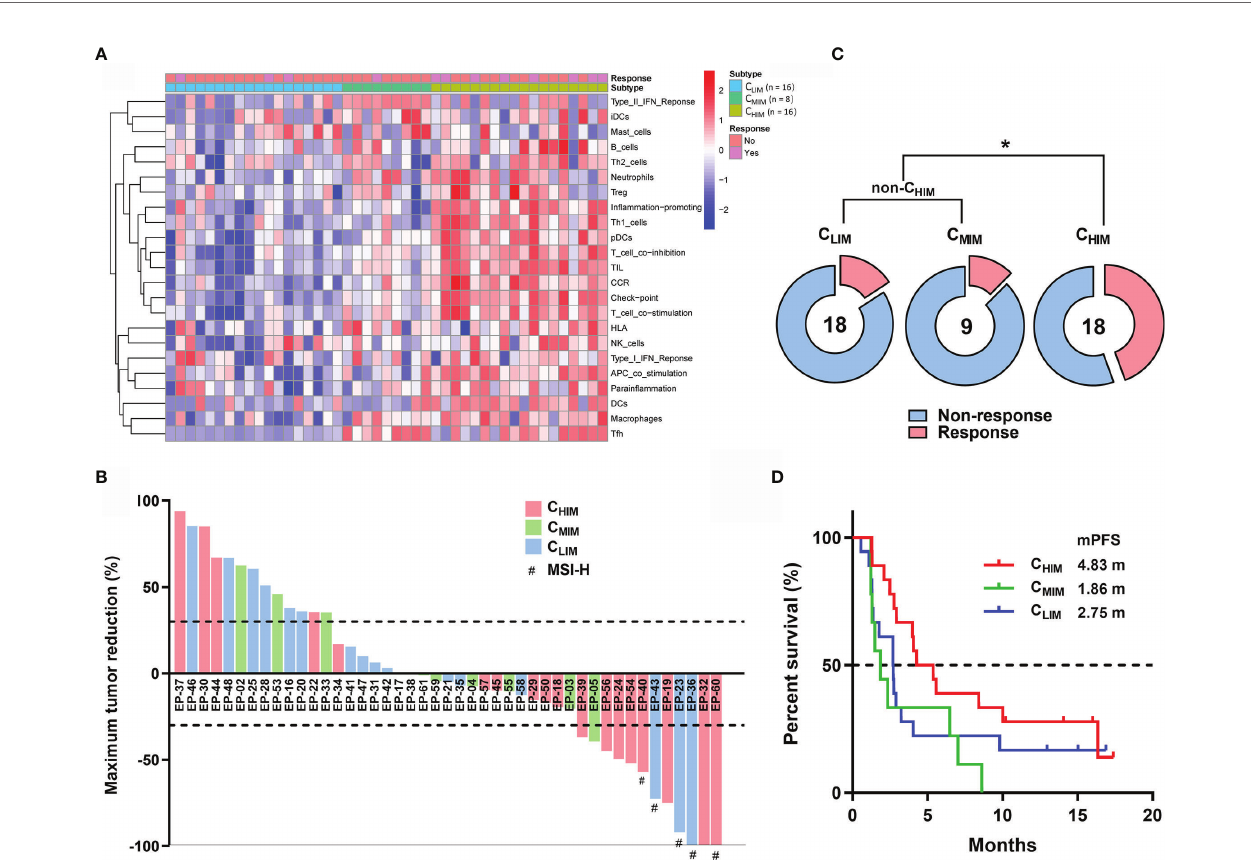
FIGURE 8 | Clinical outcome prediction by immune subtypes in patients treated with ICIs. (A) Clustering of patients in PRJEB25780 cohorts. (B) Waterfall plot of responses to ICIs (pembrolizumab) according to immune subtypes. The lower dotted line represents tumor reduction of 30% per RECIST and de fi nes partial responses. (C) Frequencies of patients with and without response to ICIs between different immune subgroups. (D) Kaplan-Meier plot of progression-free survival after treatment with ICIs between immune subtypes. Median progression-free survivals (mPFS) are listed in the panel. * P <